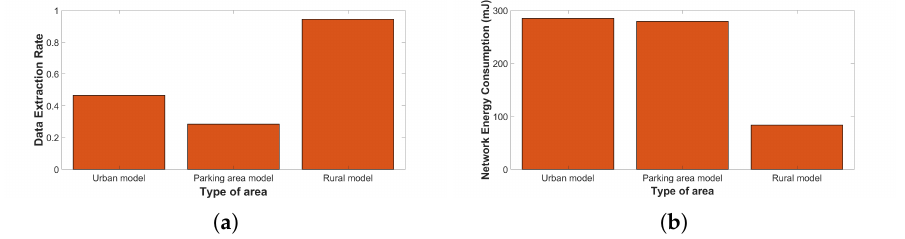
Figure 8. Parking model: ( a ) DER relative to the type of area; and ( b ) NEC relative to the type of